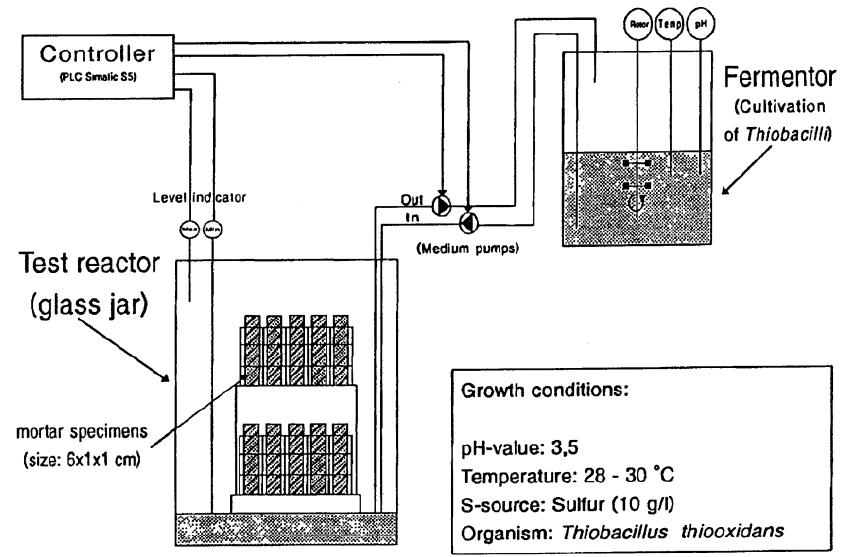
Figure 6. Heidelberg chamber for biogenic acid corrosion [56].